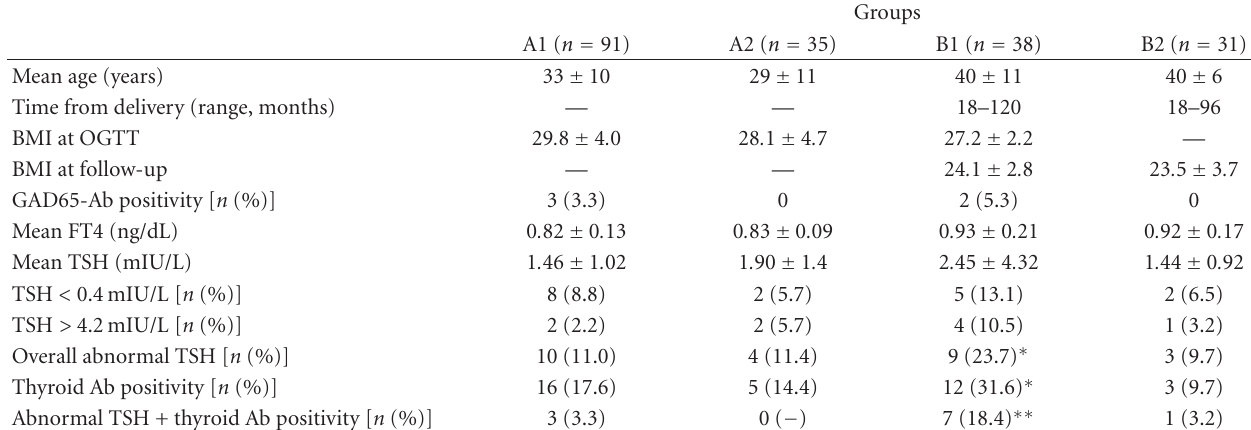
Table 1: Clinical characteristics and laboratory data of the four groups of women evaluated.